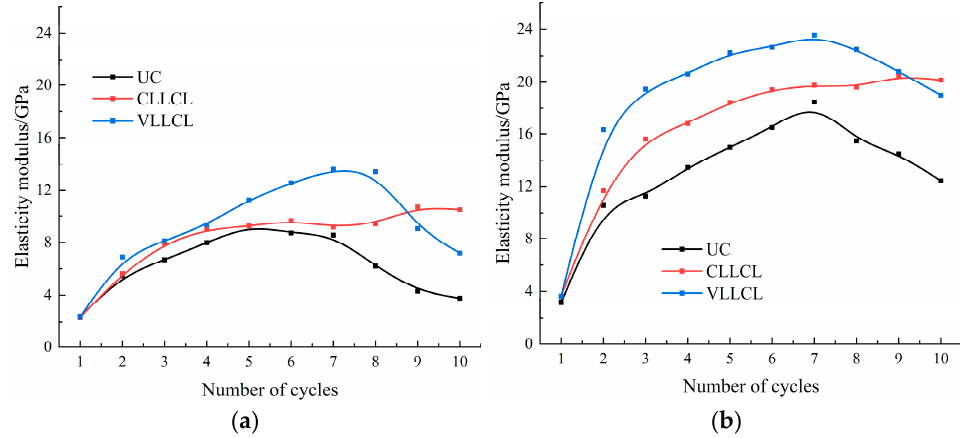
Figure 8. The relationship between the elastic modulus and the number of cycles. ( a ) Sandstone; ( b ) granite.